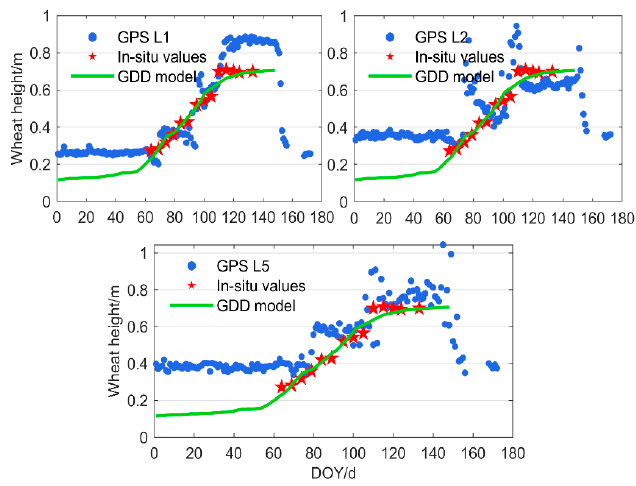
Figure 7. Wheat height retrieval with GPS.